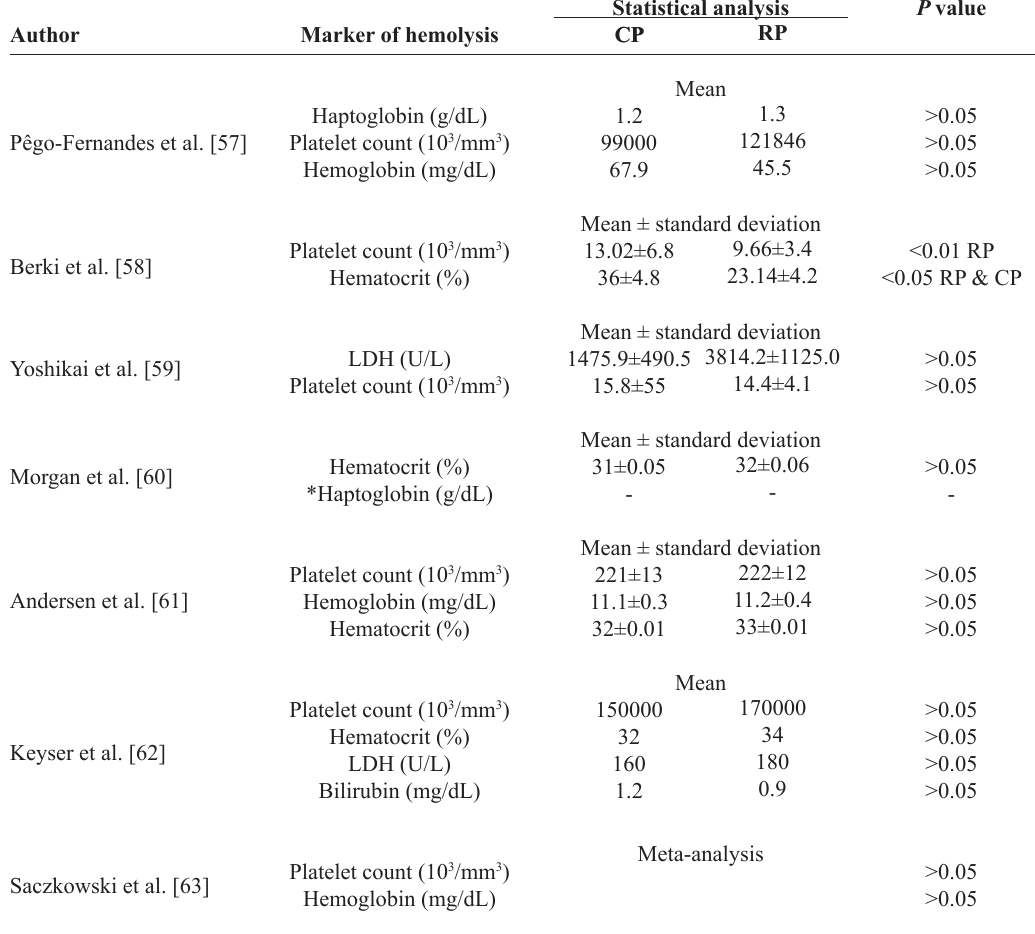
Table 1. Comparative analyses of roller vs. centrifugal pumps for cardiopulmonary bypass, using markers of hemolysis as outcome